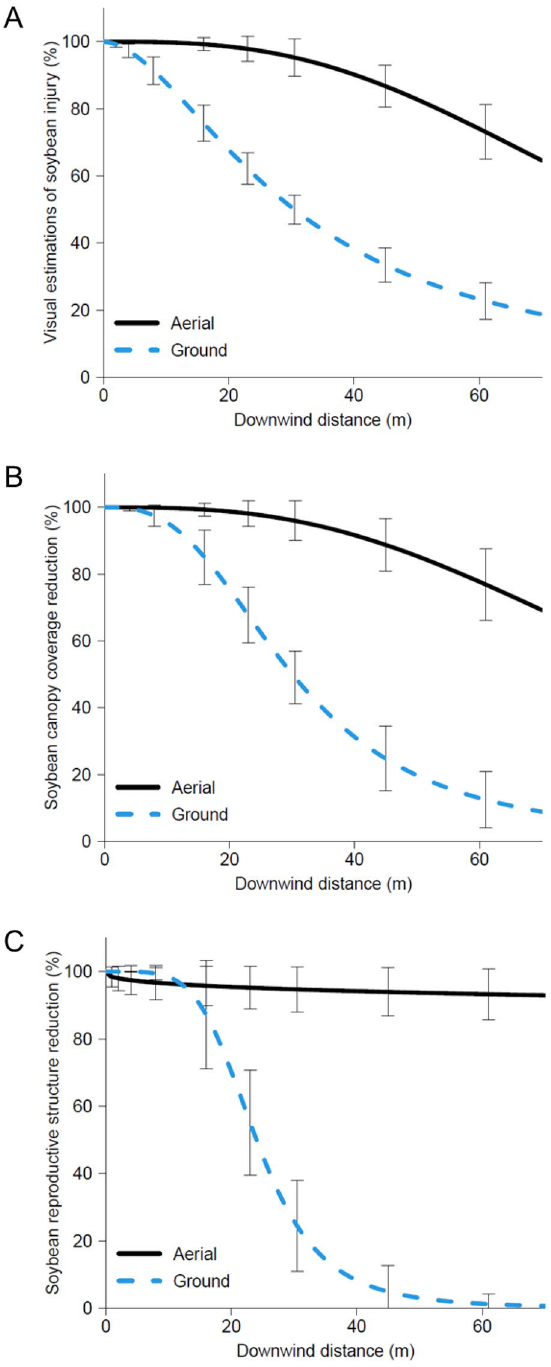
Figure 4. Visual estimations of soybean injury ( A ), soybean canopy coverage reduction ( B ), and soybean reproductive structure (flowers and pods) reduction ( C ) 35 days after exposure modeled using four parameter log-logistic regressions to evaluate measured spray drift from ground and aerial application equipment. The nontreated control plants averaged 54% canopy coverage and 101 total number of reproductive structures per